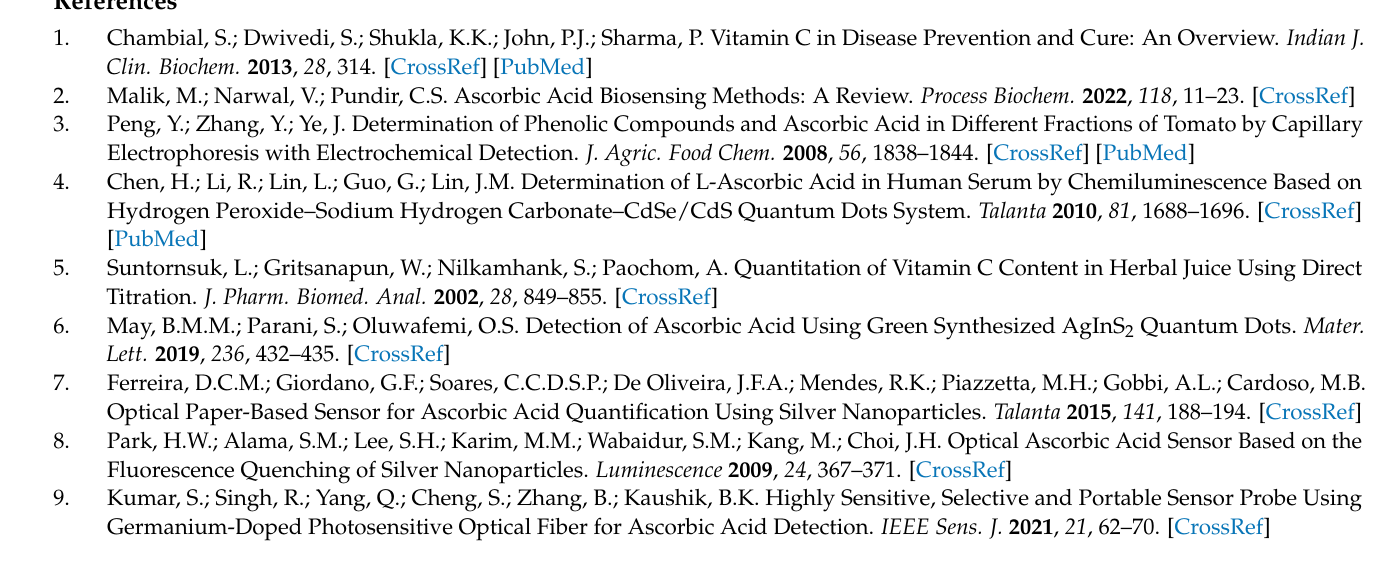
Table S1:Content of Eu and Cu (wt.%) in NH 4 [Cu 3 ( µ 3 -OH)( µ 3 -4-carboxypyrazolato) 3 ] after different times of cation-exchange process based on ICP-OES; Figure S2: Excitation spectra of